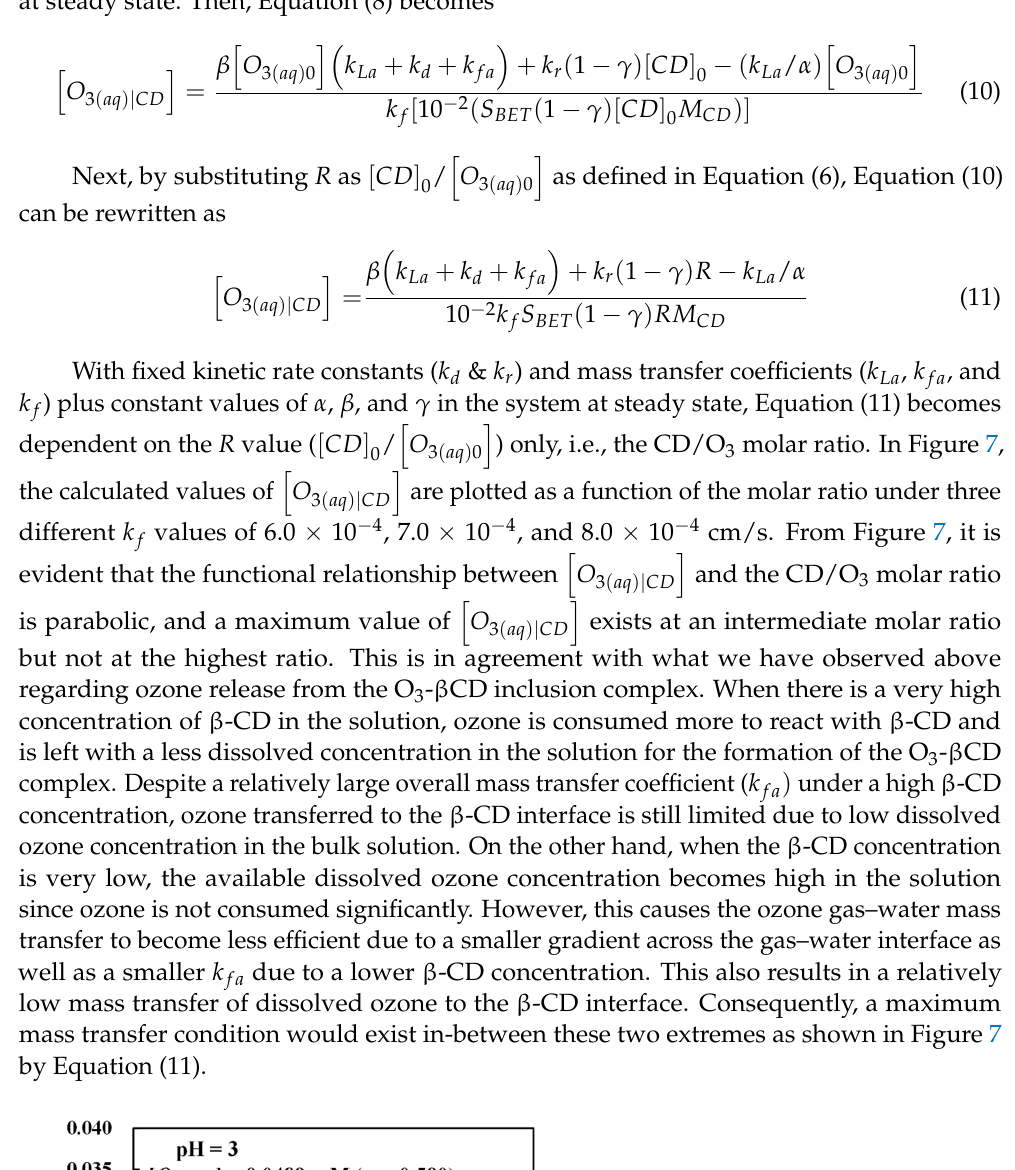
Figure 7. Calculated ozone concentrations at the water-CD interface ( [𝑂 (cid:2871)((cid:3028)(cid:3044))|(cid:3004)(cid:3005) ] ) as a function of CD/O 3 molar ratio under three different mass transfer coefficients ( 𝑘 (cid:3033) ) at pH 3 using Equation (11). Other pertinent parameters except for the 𝑘 (cid:3033) value in the model are listed in Table 1.